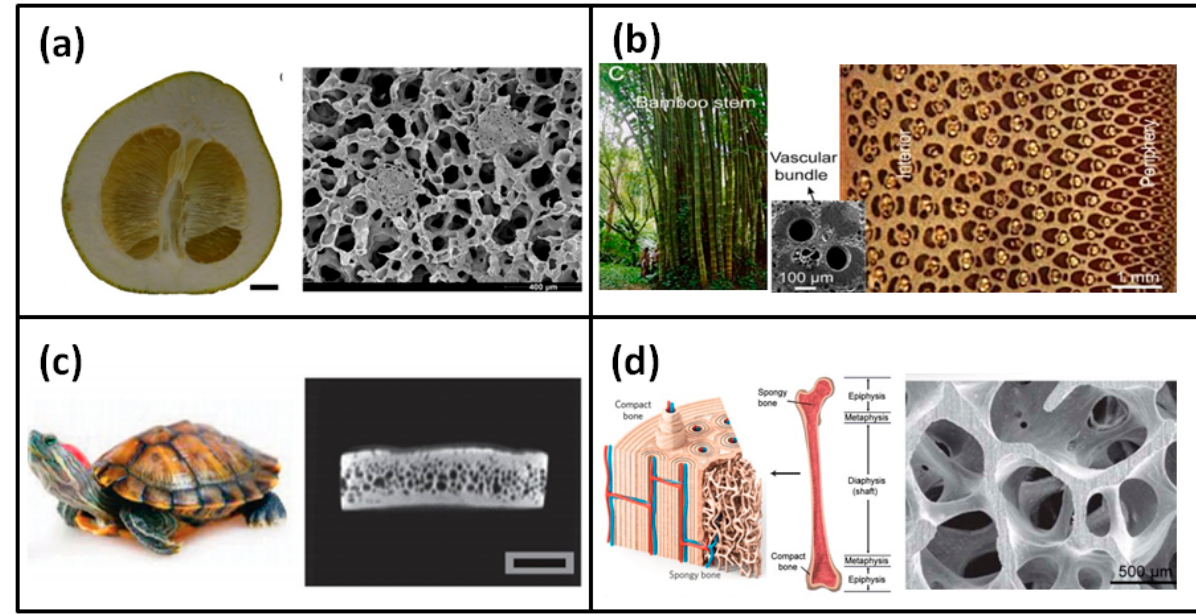
Figure 1. Cellular medium materials in nature ( a ) grapefruit peel, ( b ) bamboo, ( c ) turtle shell, and ( d ) bone [2,18].